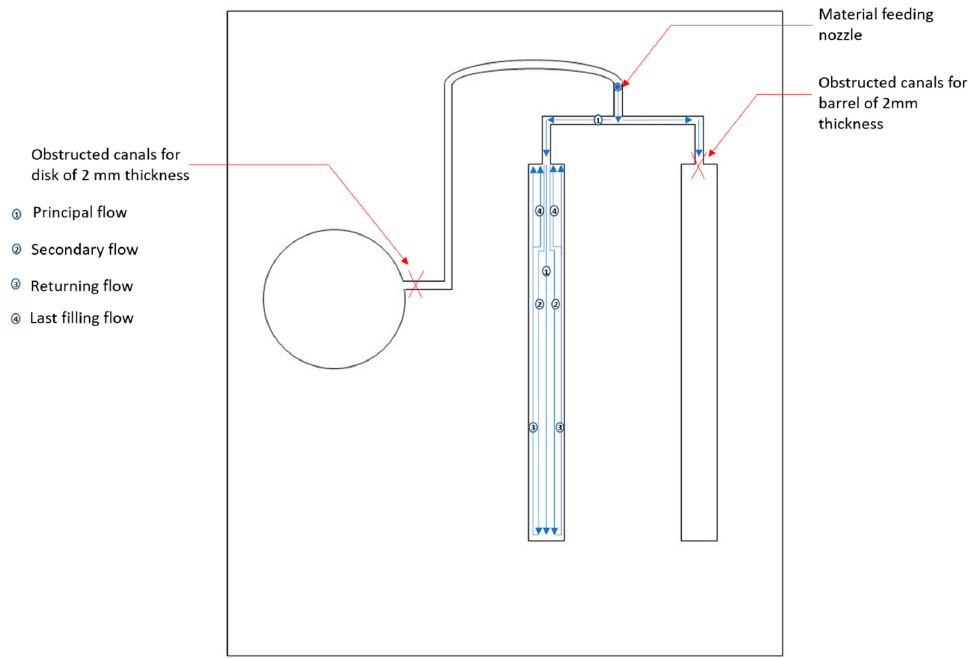
Figure 2. Diagram of the filling process of the specimen for the tensile test.